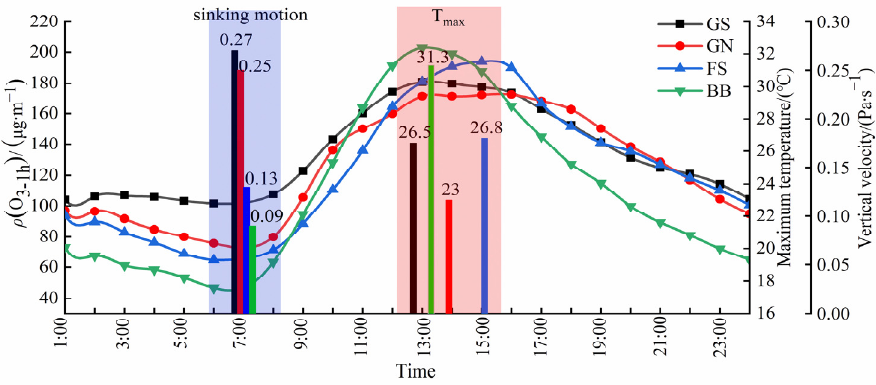
Figure 5. Diurnal variation of the O 3 concentration for four SWPs in PT during spring from 2015 to 2020.